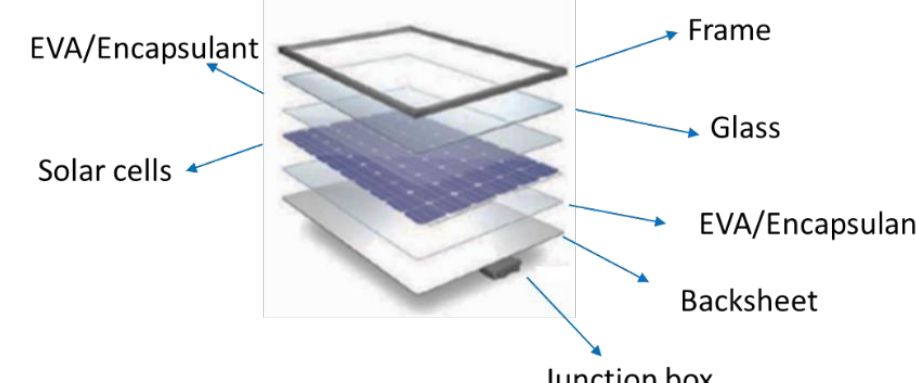
Figure 1. PV module layers [22]. Table 2. PV module fault classification.